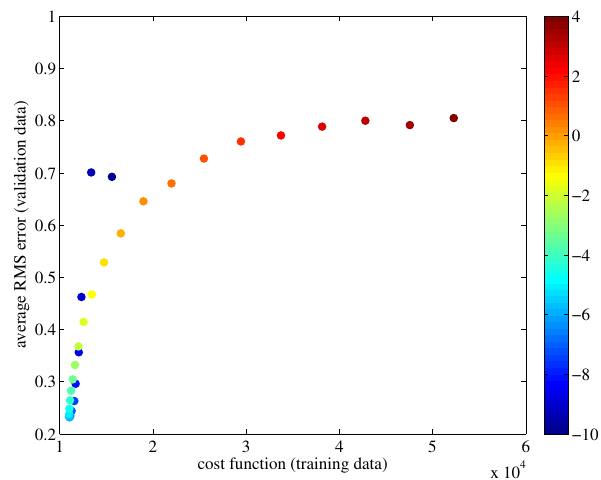
Figure 4. Negative log likelihood of the training data vs. the average rms error of the filter with the validation data. Colors indicate the Figure 4: Negative log-likelihood of the training data vs. the average RMS error of the filter with the validation logarithm of the model error variance λ data. Colors indicate the logarithm of the model error variance λ . where d ( x i ,x j ) denotes the distance between two grid points, σ 2 > 0 is the variance parameter, α > 0 is the 216 correlation length and τ 2 > 0 is a small positive nugget term that ensures that the matrix is positive definite. 217